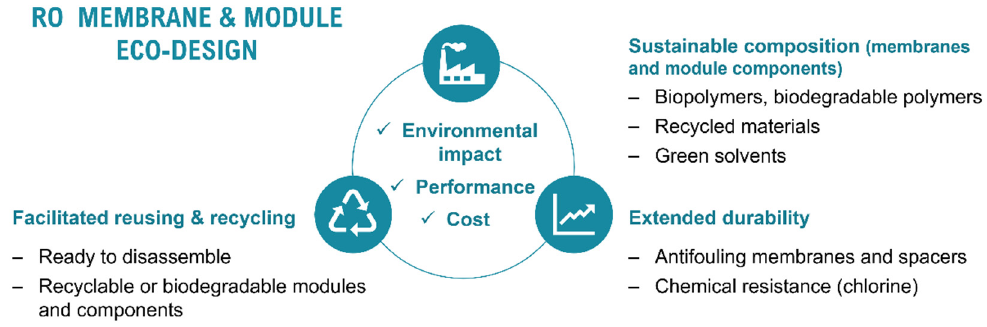
Figure 3. Main aspects to be considered in RO membrane and module eco-design.